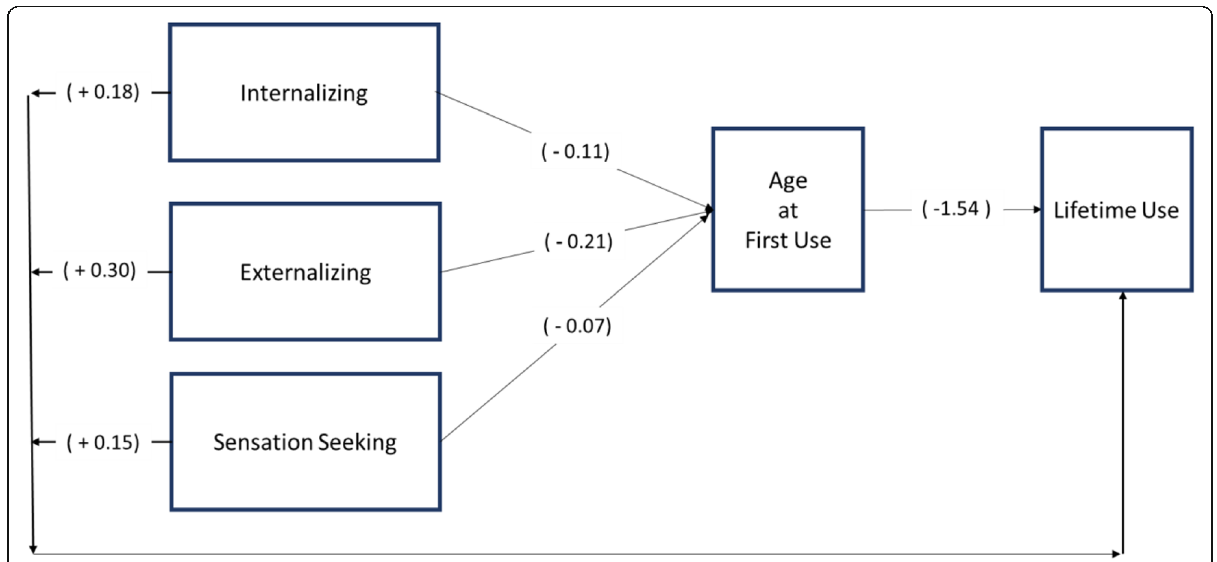
Fig. 1 Significant indirect effects are also present for Internalizing ( B = 0.18), Externalizing ( B = 0.33) and sensation seeking ( B = 0.10), p < 0.05. Estimates are in parentheses. Relationships between youth factors and lifetime tobacco and cannabis use mediated by age at first use of tobacco or